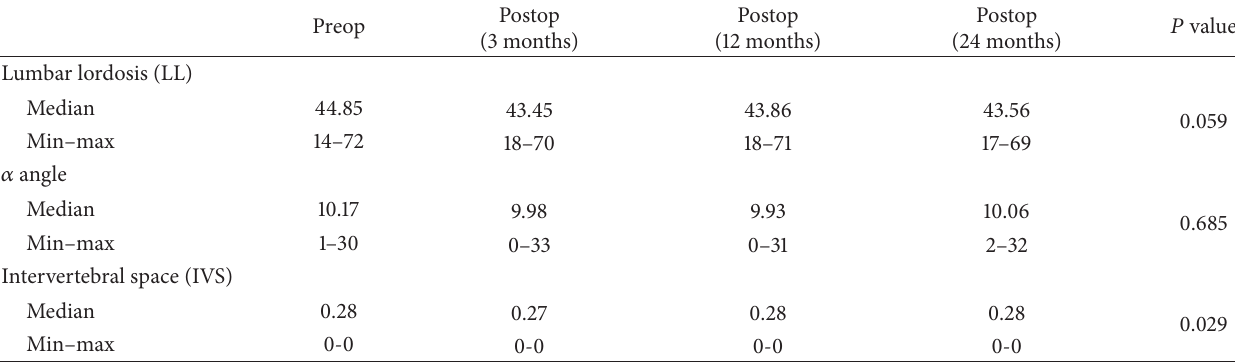
Table 1: Results of radiological lumbar lordosis, 𝛼 angle, and intervertebral space (IVS). Postop Preop